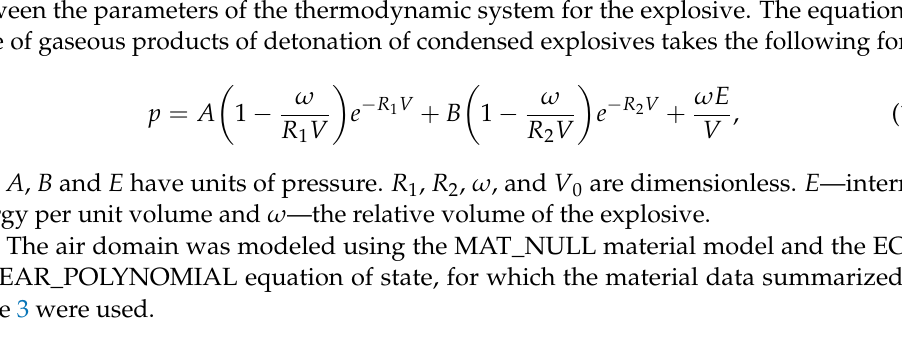
Table 3. Air material data with the equation of state